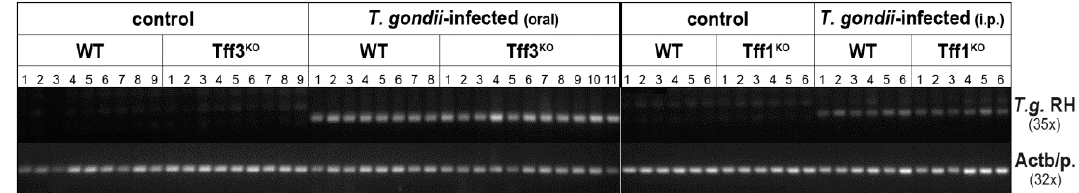
Figure 3. PCR analyses of genomic DNA from the spleen for the T. gondii RH strain repeat region (T.g. RH). T. gondii DNA was monitored seven days after oral T. gondii infection and four weeks after i.p. infection, respectively. As a control, DNA from the β -actin promoter (Actb/p.) was amplified. The number of amplification cycles is given in parentheses.